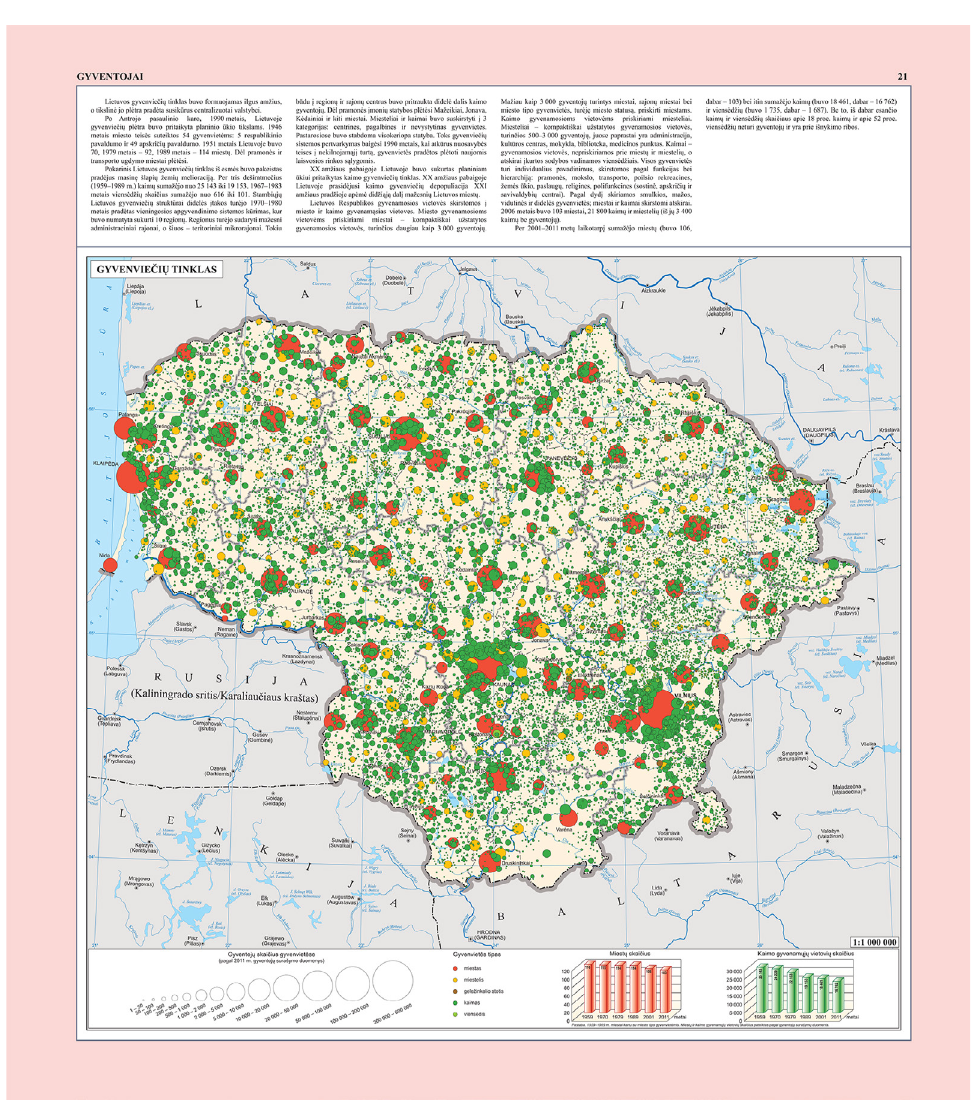
Fig 2. The settlements network – their types and number of inhabitants, with explanatory text (reduced – original scale and development”. The network of settlements (fig. 2), density of population and its dynamics, density of population in cities, natural decrease or increase in population, proportion of men and women and its dynamics, marriages, divorces, dynamics of number of families, numbers of children in families (fig. 3), the structure of the age of population and its changes, national